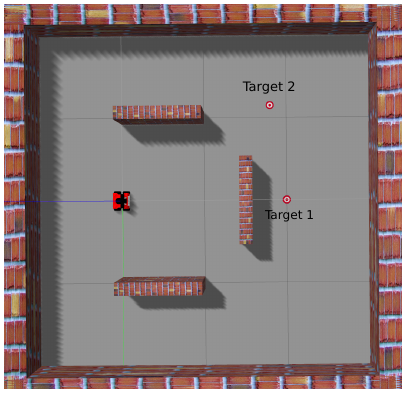
Figure 3. The virtual training environment simulated in gazebo. A Husarion robot is used as the platform of training are close to zero. The exploration noise is modeled as an Ornstein-Uhlenbeck process with parameters, σ = 0 . 2